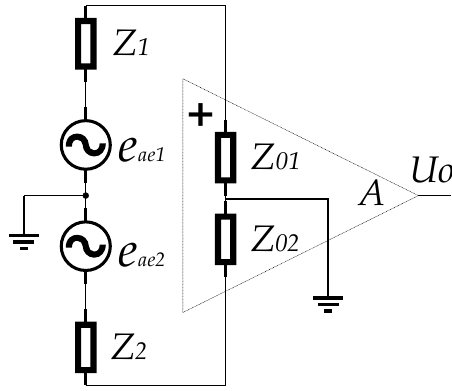
Figure 8. Equivalent circuit diagram of the